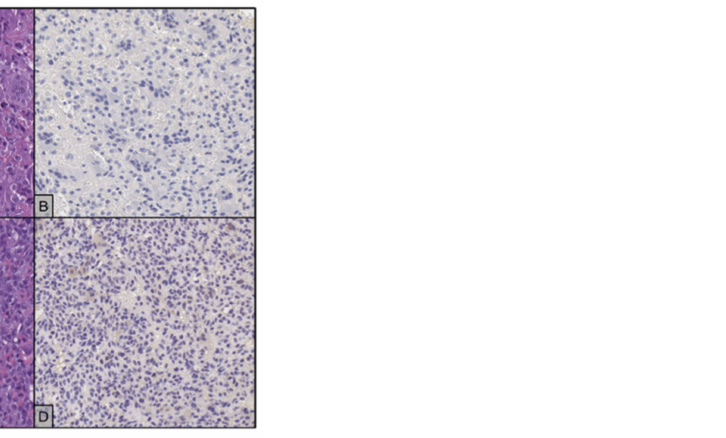
Figure 4. ( A ) The lesion is composed by multinucleated and mononuclear cells (H&E stain, 20 × ); the giant cells have hyperchromatic, homogenous nuclei, while the mononuclear cells tend to present slightly larger nuclei with finely dispersed chromatin and evident nucleolus. ( B ) Both cell populations test negative for H3F3A immunostaining (20 × ). ( C ) Recurrent disease shows proliferation of atypical, round cells, with no evidence of giant cells. (H&E stain, 20 × ). ( D ) H3F3A immunostaining is negative in the neoplastic cells (20 ×